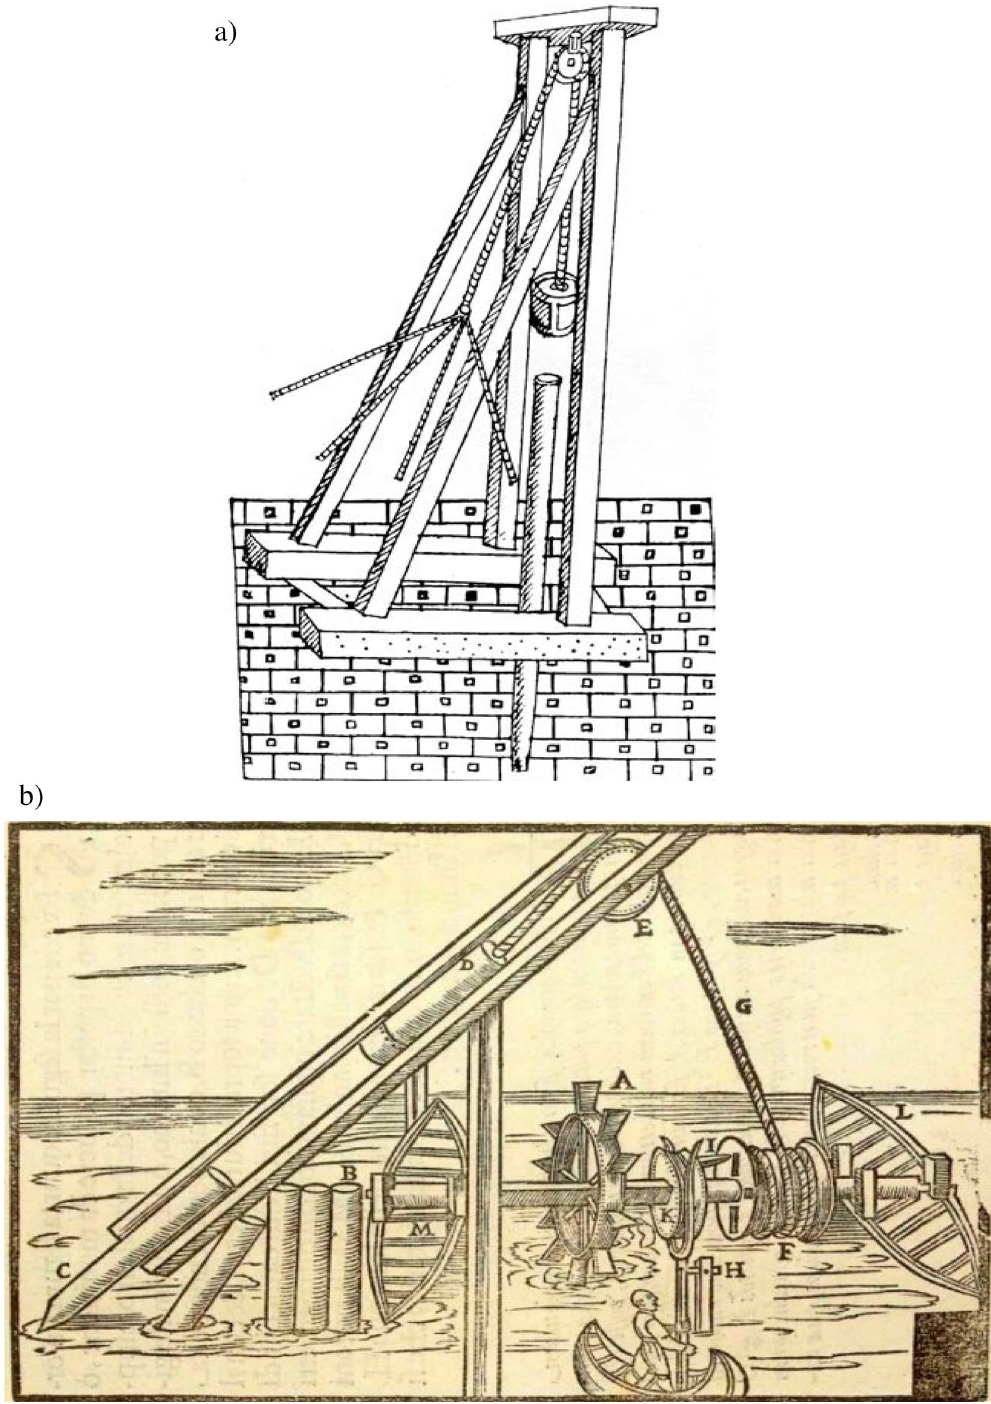
Fig. 13 a Pile driving machine and plan view of the arrangement of ashlars with holes passed through them. b Pile driving machine driven by a hydraulic wheel with a skewer clutch, (Ramos 1985; Rojas